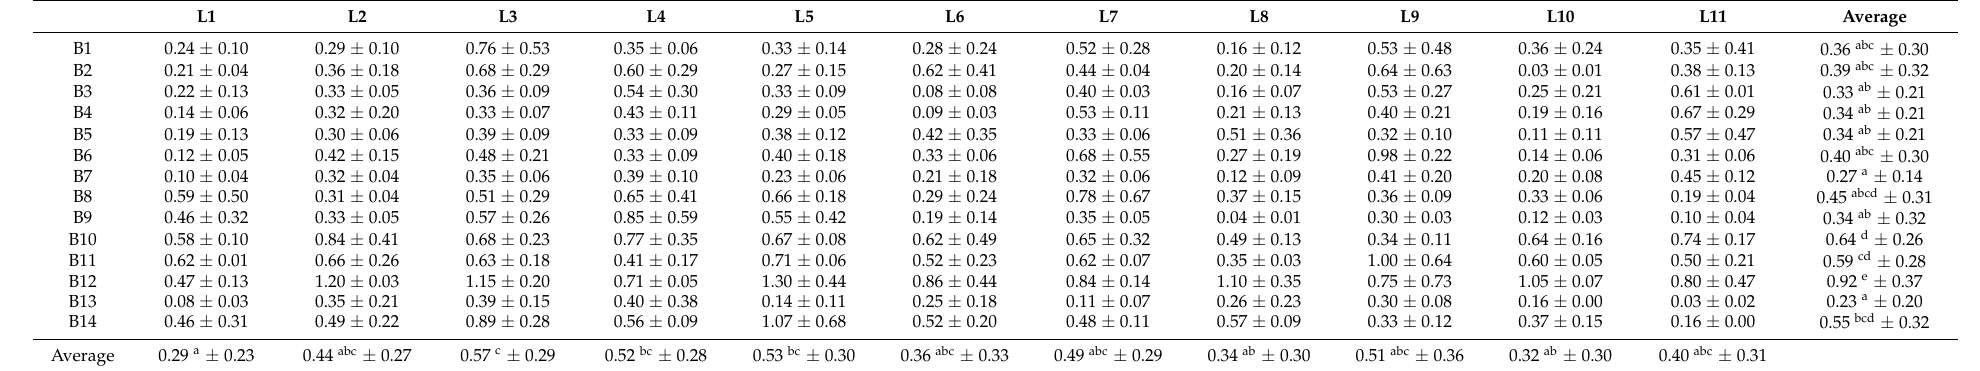
Table 2. Mean of maximum growth rate values (1/h) ± standard deviation observed in co-cultivation with each LAB strain (from B1 to B14) crossed with each yeast strain (from L1 to L11) in reconstituted bovine sweet whey.